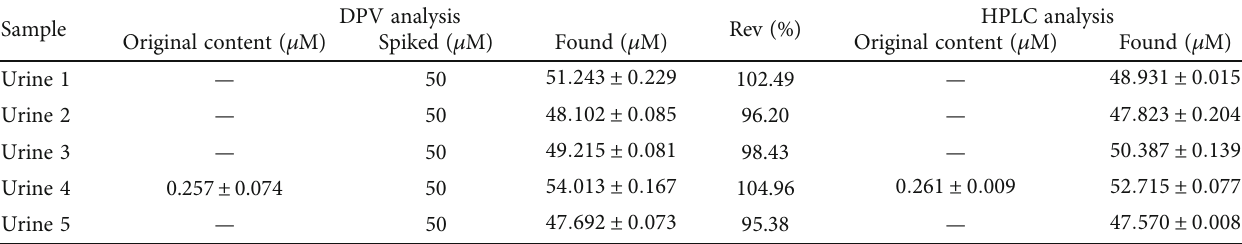
Table 4: The results of DCF analysis in urine by the proposed DPV method and